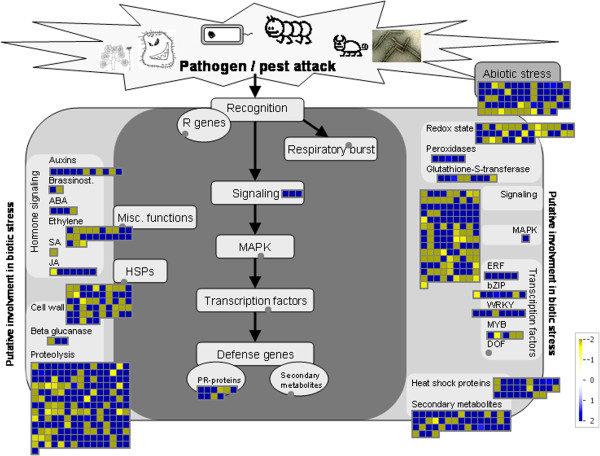
Transcriptional changes induced by T. viridana feeding in both T- and S-oaks. All transcripts induced by T. viridana feeding in both T- and S-oaks were mapped to the 'Biotic stress’ drawing in the MapMan tool [30]. Blue boxes, transcripts up-regulated after feeding in both T- and S-oaks (TIND > = 1.5 and SIND > = 1.5; mean value of TIND and SIND was mapped); yellow boxes, transcripts down-regulated after feeding in both T- and S-oaks (TIND < = -1.5 and SIND < = -1.5; mean value of TIND and SIND was mapped). Dots representing putative metabolites appear in grey as no related data were mapped.